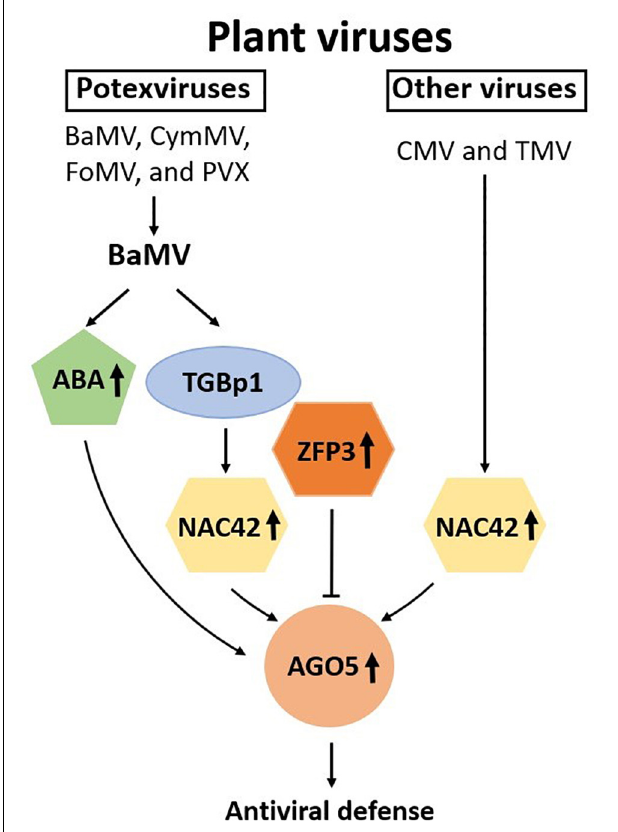
FIGURE 8 | Schematic representation of the involvement of NAC and ZFP transcription factors and ABA in the regulation of NbAGO5 expression in response to virus infection. Plant argonautes (AGOs) play an important role in antiviral defense. The expression of NbAGO5 gene is strongly induced after virus infection in N. benthamiana . NbNAC42 and NbZFP3 positively and negatively regulate the expression of NbAGO5 , respectively. The plant hormone ABA, whose biosynthesis has been shown to be activated by BaMV infection (Alazem et al., 2014), is also involved in the induction of NbAGO5 promoter activity. TGBp1, a BaMV-encoded protein, may regulate NbAGO5 expression and plant defense response through activation of the NbNAC42